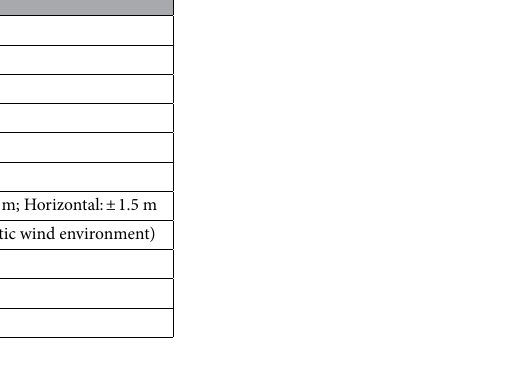
Table 1. Parameters of DJI M600pro UAV.